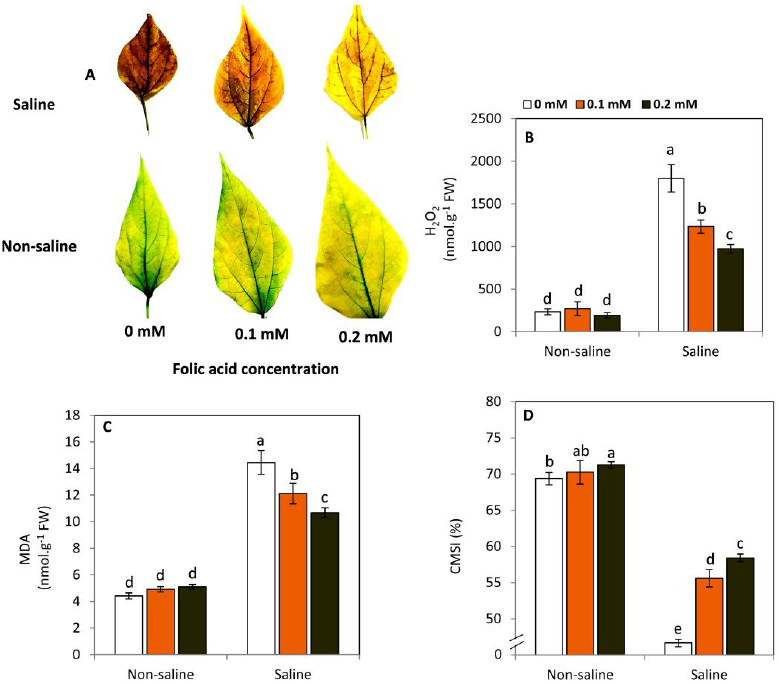
Figure 3. Effect of exogenous folic acid (FA; 0, 0.1, and 0.2 mM) on the histochemical detection of H 2 O 2 using diaminobenzidine (DAB) staining method ( A ), the concentration of H 2 O 2 ( B ), lipid peroxidation as indicated by malondialdehyde, MDA ( C ), and cell membrane stability index, CMSI ( D ), of snap bean plants grown under non-stressed and saline-stressed (50 mM, NaCl) conditions. Values are the averages of three replicates ± SD. Different letters indicate significant differences according to Duncan’s multiple range tests ( p < 0.05). Dark-brown DAB staining color indicates increase the accumulation of H 2 O 2.